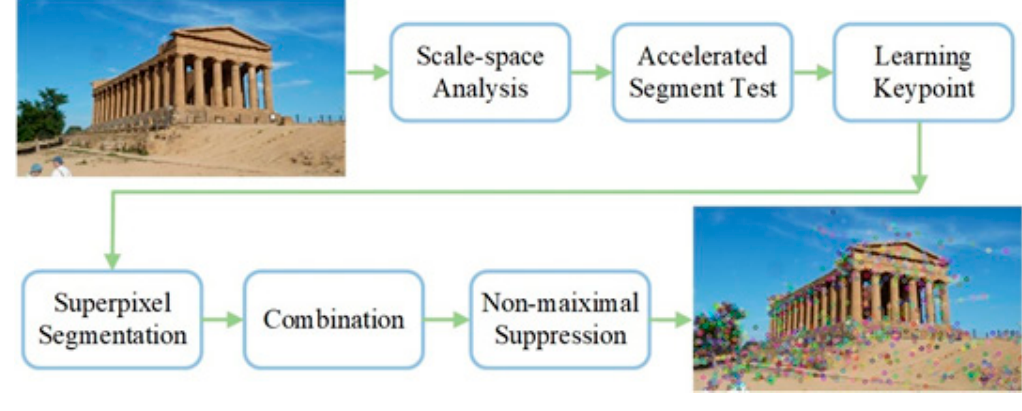
Figure 3. Joint keypoint detection.